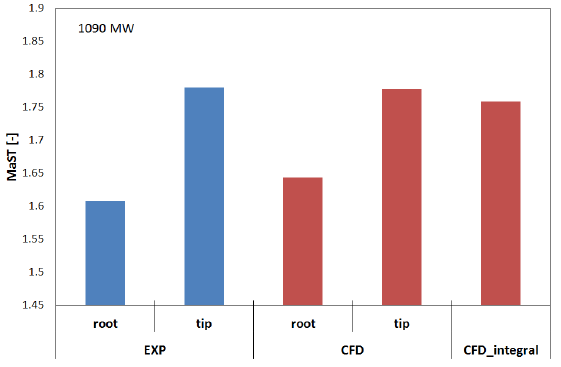
Figure 13. Stage Mach number.